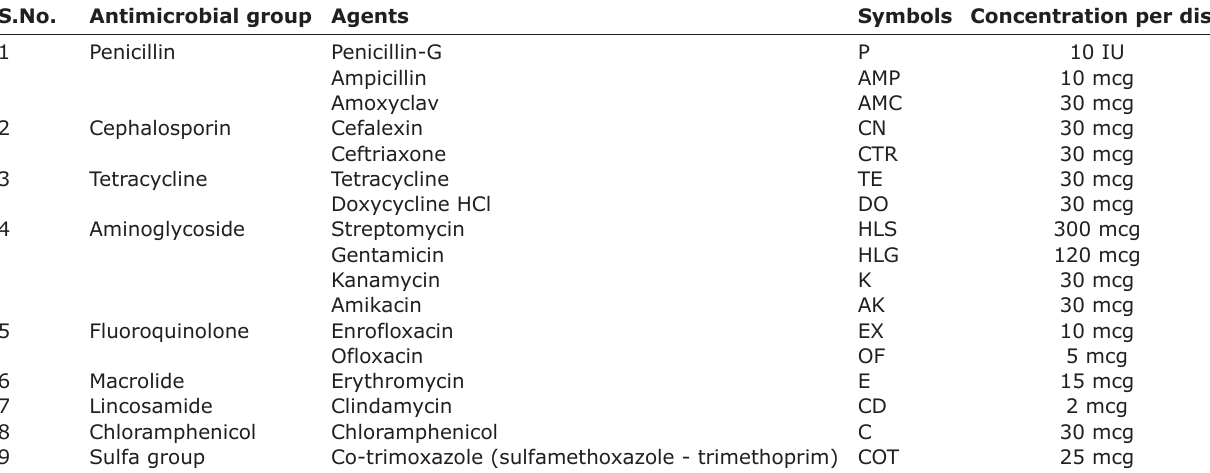
Table-1: Groups of antimicrobial agents and their concentrations. S.No.